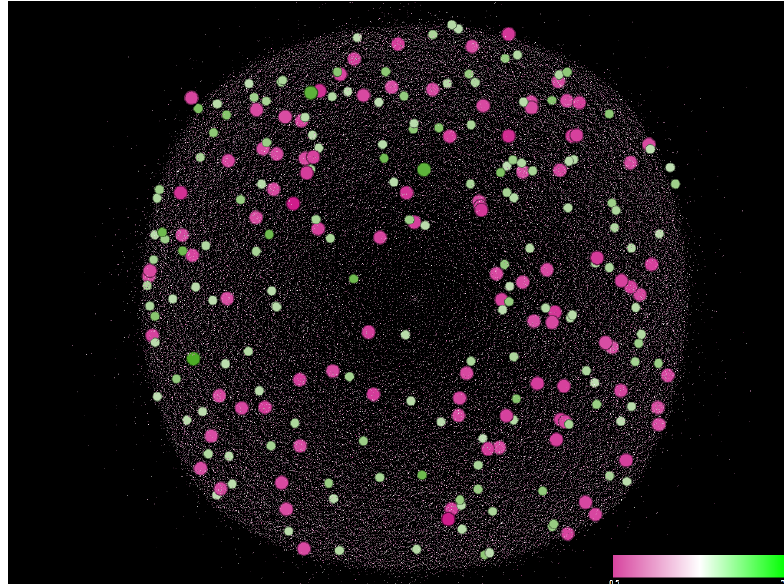
Figure 6. Congestion rate ( CR 2 i ) in the network.